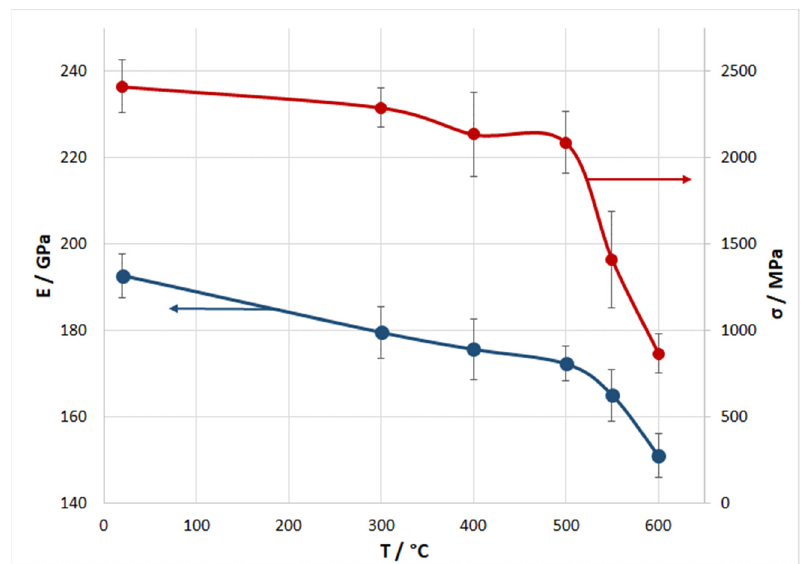
Figure 6. Dependence of the strength and elastic modulus of the composite wire at three-point bending on the heat-treatment temperature.